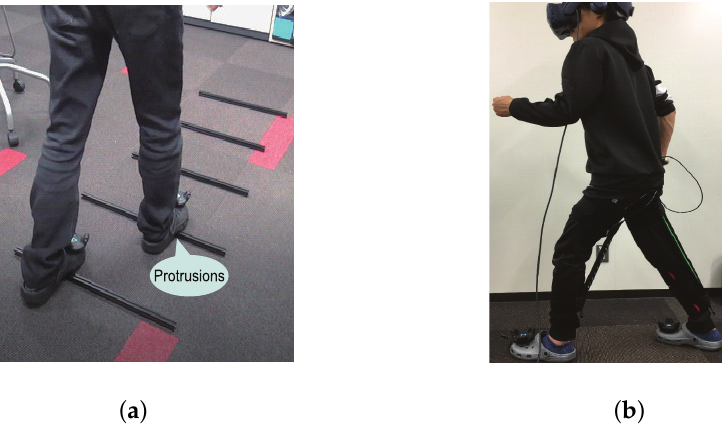
Figure 12. Scenes of the subjective evaluation experiment: ( a ) conventional method; ( b ) the developed illusionary